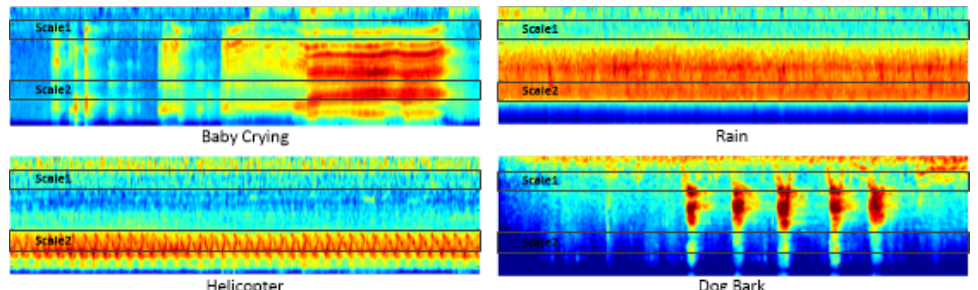
Figure 1. Four typical log Gammatone spectrograms of crying baby, rain, helicopter, and dog bark over the entire frequency band, where the horizontal axis represents time dimension and the vertical axis represents frequency